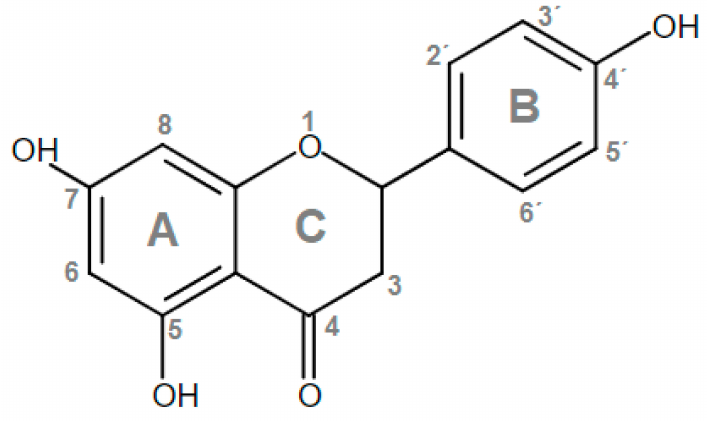
Figure 1. Chemical structure of naringenin